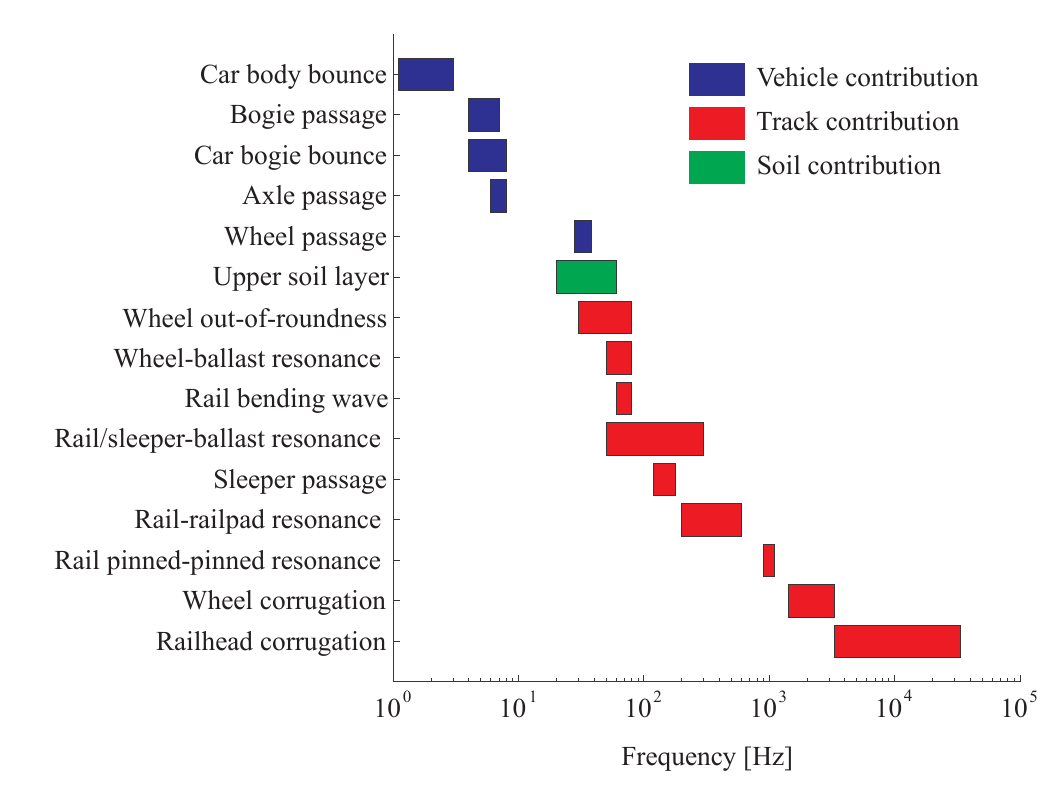
Figure 6. Main contribution of dynamic vehicle/track and soil interactions (with permission from